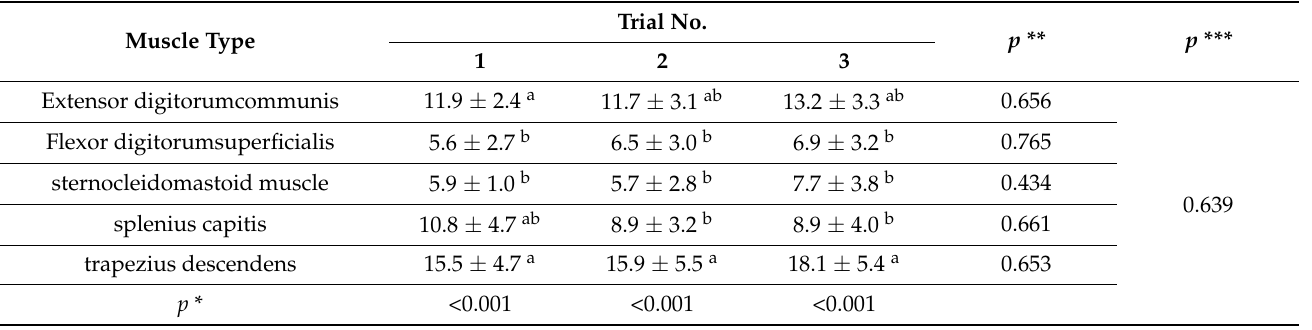
Table 3. Comparison of mean RMS EMG (% MVC ) in the first, second, and third repetitions of the intraoral scanning task.